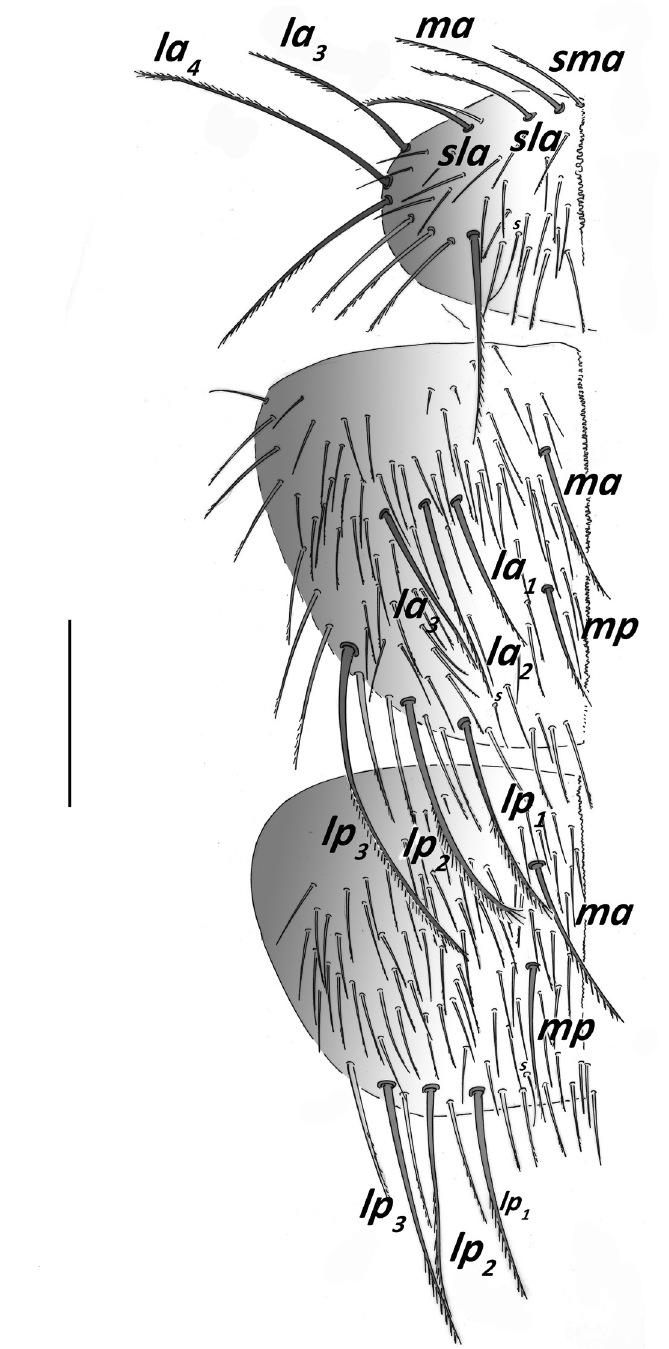
Fig. 124. Plusiocampa ( Plusiocampa ) rhea Sendra sp. nov., holotype, ♂, 4.9 mm long, from Ideon Antron Cave entrance, Anogeia, Crete (MZB 2019-1033). Pronotum, mesonotum and metanotum, left side (s = setiform sensillum). Scale bar: 0.3